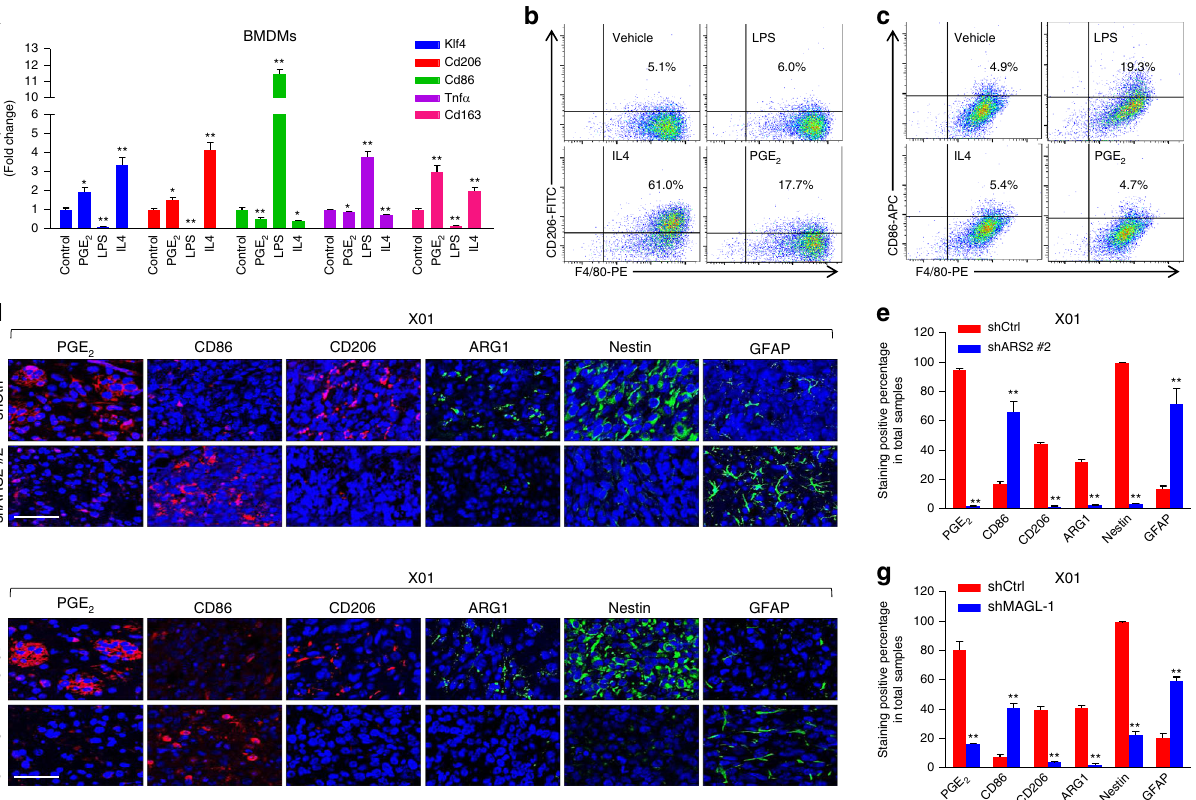
Fig. 6 The ARS2/MAGL module regulates tumorigenesis through PGE 2 – mediated induction of M2-like TAMs. a qRT-PCR analysis of Klf4, Cd206 (Mrc1), Tnf α , and Cd163 in bone marrow derived-macrophages (BMDMs) after induction with PGE 2 (10 μ M), LPS or IL4, or treatment with control. All error bars represent mean ± SEM ( n = 3). * P < 0.05, ** P < 0.01. b , c Expression of CD86 ( b ) and CD206 ( c ) in BMDMs treated with PGE 2 (10 μ M), LPS, IL4, or vehicle control, and in negative BMDM control by fl ow cytometry. F4/80 was co-stained for macrophagic population veri fi cation. d , e Representative IF images ( d ) and corresponding quanti fi cation ( e ) of PGE 2 , CD86, CD206, ARG1, Nestin, and GFAP in brain tissues from X01-shCtrl and X01-shARS2 #2 orthotopic xenograft mouse model. Scale bar, 50 µ m. All error bars represent mean ± SEM ( n = 3). ** P < 0.01, t -test. f , g Representative IF images ( f ) and corresponding quanti fi cation ( g ) of PGE 2 , CD86, CD206, ARG1, Nestin, and GFAP in brain tissues from X01-shCtrl and X01-shMAGL-1